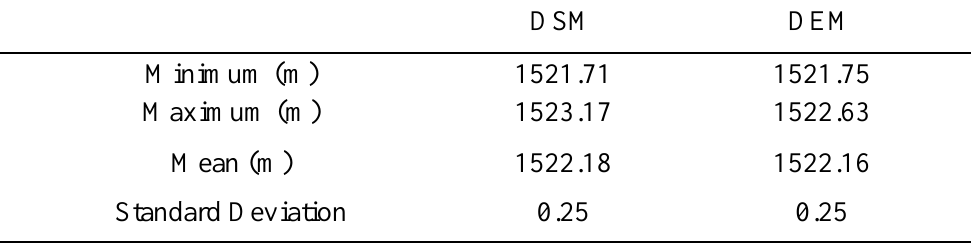
Table 1. Comparison of elevation values between DSM and DEM for the field